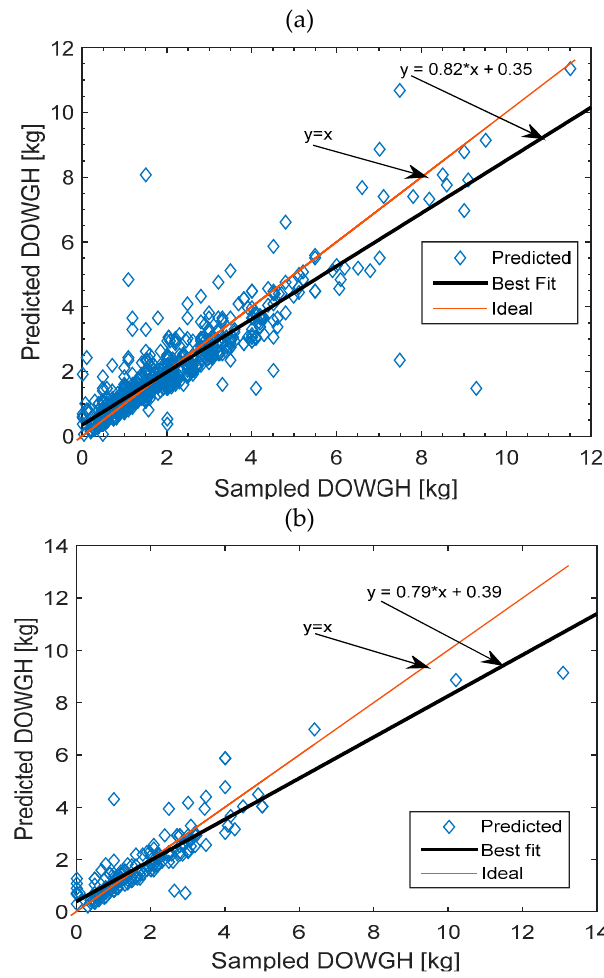
Figure 3. The graphical depiction of results of training ( a ) and testing ( b ) for organic composition. The testing is only slightly less fitted (reflecting as slightly less slope and higher intercept, that is, more deviated from the ideal) than the training. DOWGH means Daily Organic Waste Generated from Household.